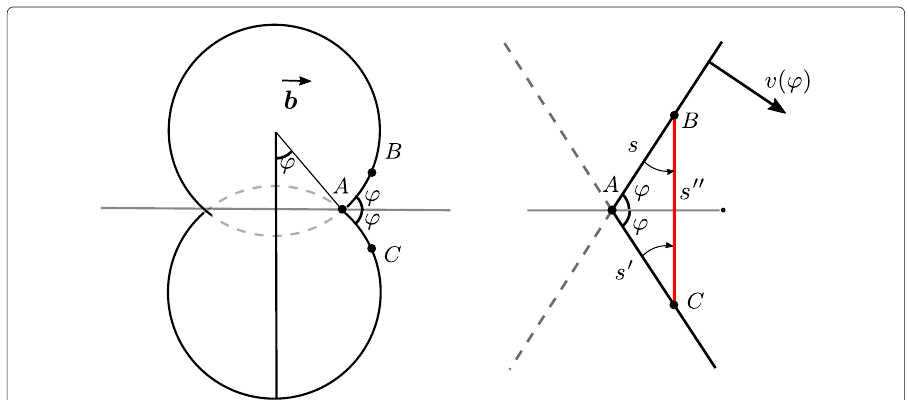
Fig. 3 Top view of a cross slip induced recombination process. Left: cross slip initiates the annihilation of near-screw segments of two merging dislocation loops. The dashed lines shows the annihilated parts of the loops. After the initiation of the cross slip, loops continue to merge by interaction between segments AB( s s s (ϕ) ) and AC ( s s s (ϕ (cid:10) ) ). Right: Recombination of segments sss (ϕ) and sss (ϕ (cid:10) ) generates a new segment sss (ϕ (cid:10)(cid:10)